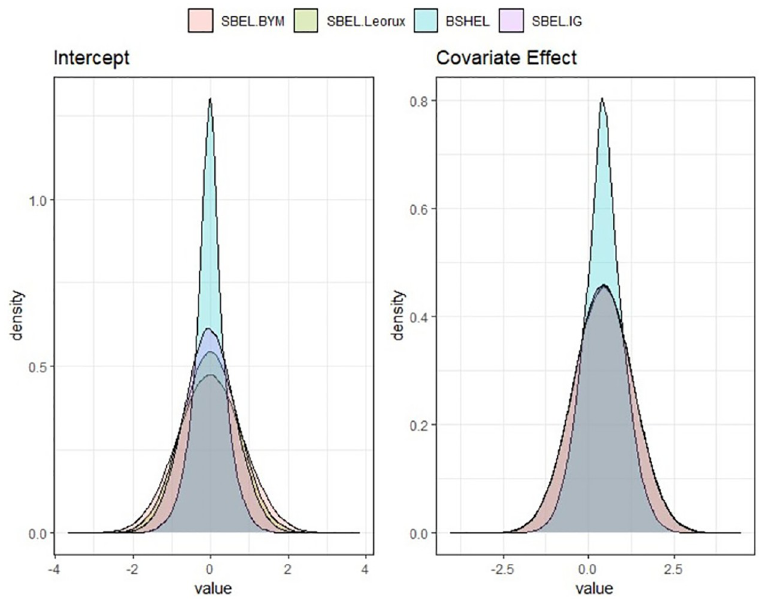
Fig 1. Posterior densities of regression coefficients β 0 and β 1 using spatial BEL models for Scottish lip cancer data.